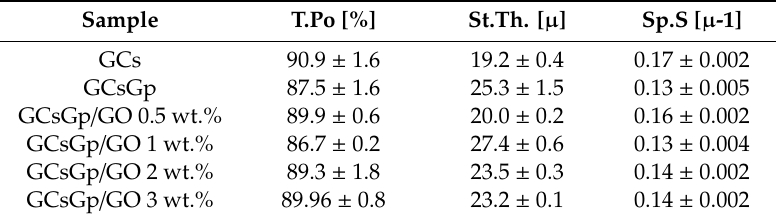
Table 1. Summary of the percentual T.Po, metric St.Th and Sp.S of the 6 specimens investigated by means of µ